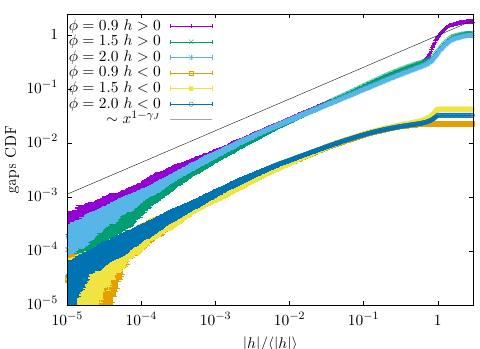
Figure 5: The positive and negative cumulative gap distribution. The y -axis of the negative gap is rescaled by an artificial factor 0.1 to improve the readability of the fig- ure. We observe that both cumulative distribution appear to be described by the same power law exponent for small argument. Data produced with system size N = 512, dimensions d = 2, averaged over 35 samples for densities φ = 0.9 and φ = 2.0 and over 46 samples for density φ =